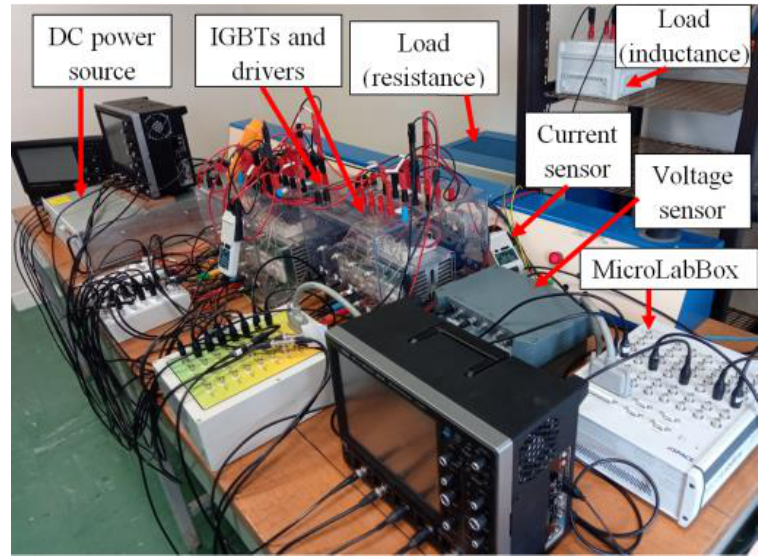
Figure 12. Experimental setup.